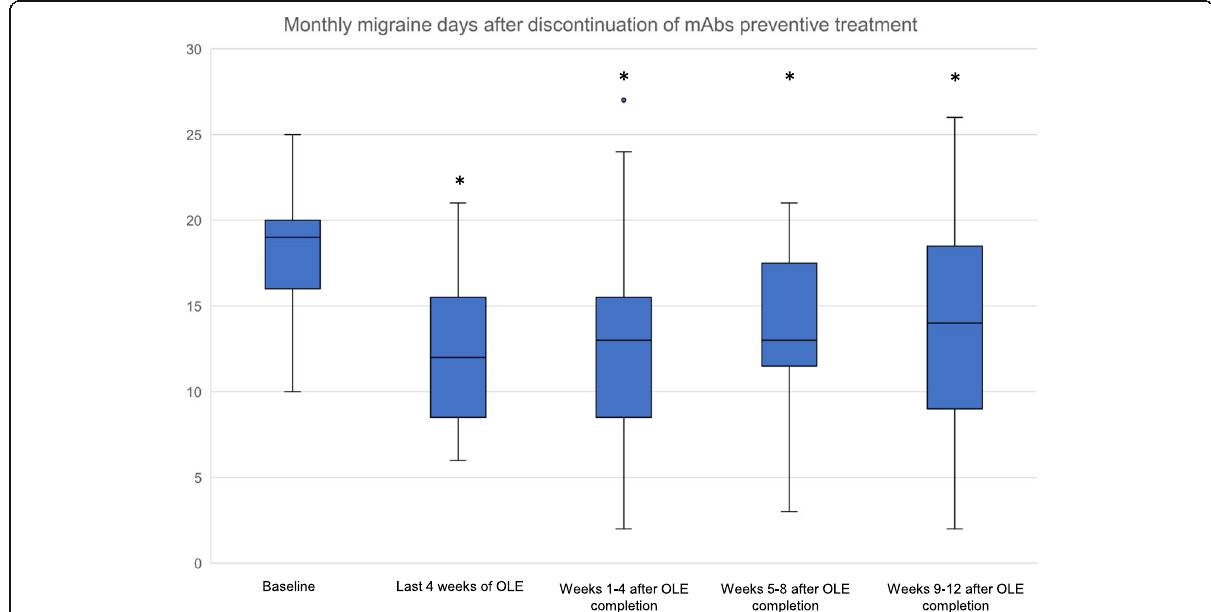
Fig. 1 Monthly migraine days during baseline, the last 4 weeks of open-label extension (OLE) and the observation period of 12 weeks-following OLE completion (pooled data). * = significant vs.